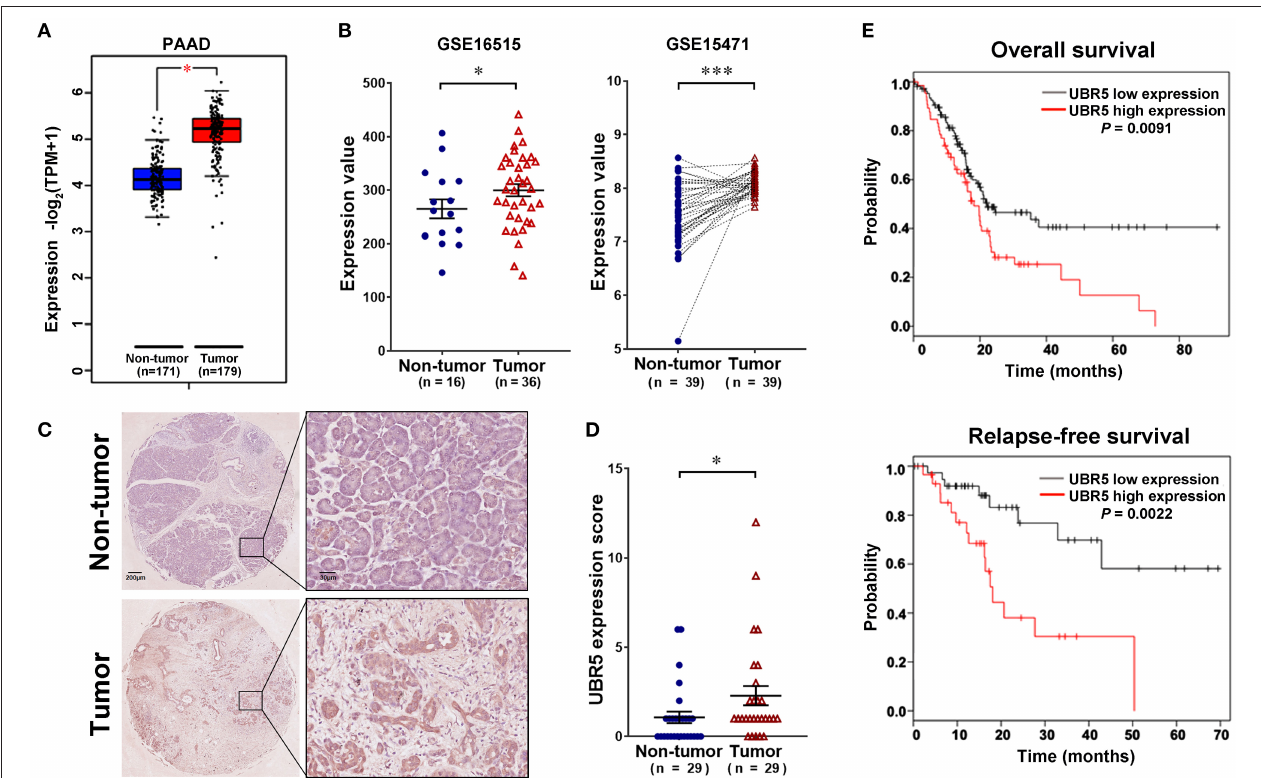
FIGURE 1 | UBR5 is upregulated in pancreatic cancer and associated with poor prognosis. (A) The analysis of UBR5 mRNA expression in 171 non-tumor pancreatic tissues and 179 pancreatic cancer tissues. (B) The mRNA expression of UBR5 from the GEO database. Representative images (C) and quantification of UBR5 staining score (D) in 29 paired pancreatic cancer tissues. A paired Student’s t test was used to compare the expression of UBR5 between pancreatic cancer tissues and normal tissues. (E) The overall survival and relapse-free survival analysis of pancreatic cancer patients based on the data from TCGA database using the web-accessible Kaplan–Meier plotter. Survival curves were calculated using the Kaplan–Meier method and analyzed by the log-rank test. *, P < 0.05; ***, P <